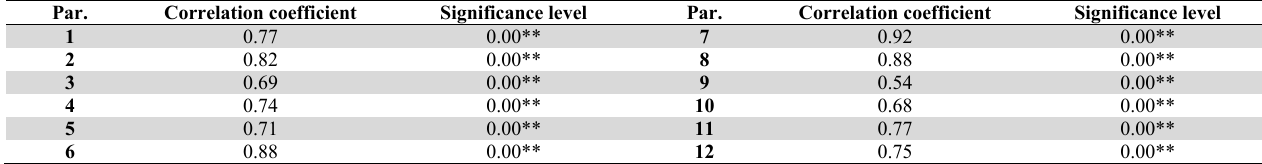
Validity of the Second Section (Credit Risk) Par.